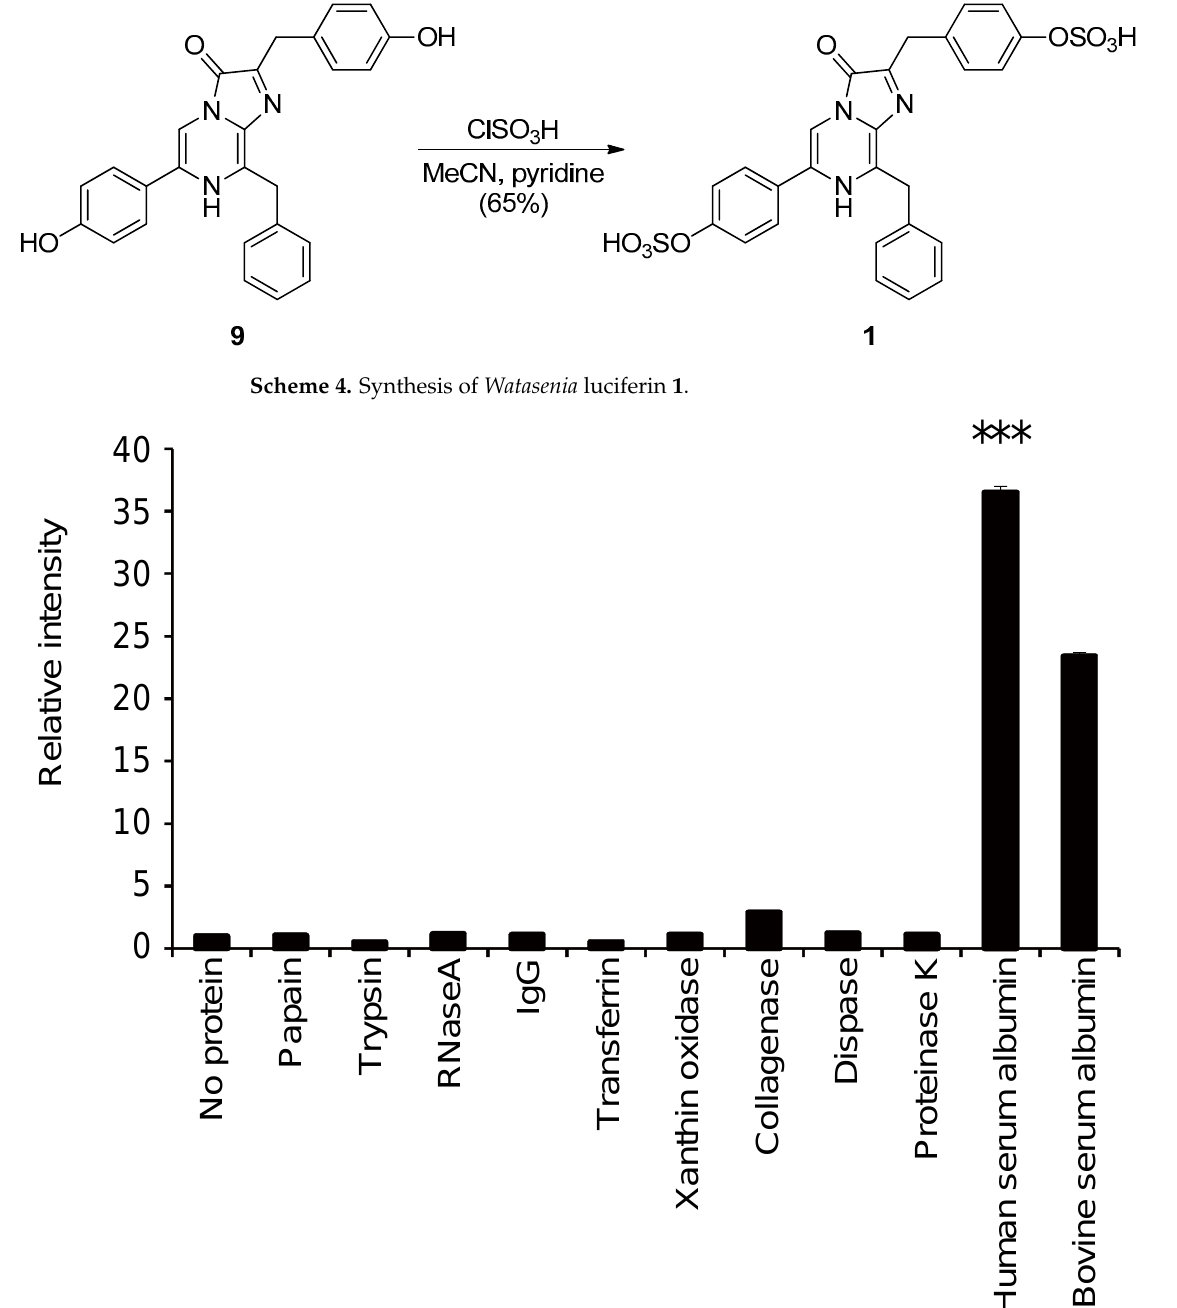
Figure 1. Relative luminescence intensity emitted by the reaction of each protein (1 mg/mL) (hori- zontal axis) with Watasenia luciferin. The values for each group were compared with human albumin values (mean ± SEM, n = 4; one-way ANOVA with Dunnett’s test, *** p < 0.001).